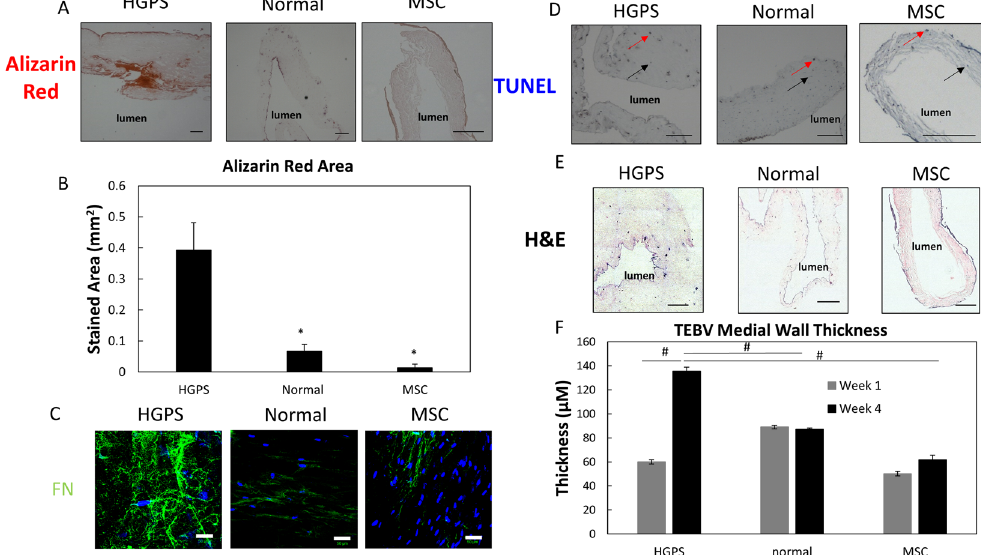
Figure 4. Progeria disease characterization of TEBVs fabricated from MSC or iPSC-derived SMC TEBVs from healthy and Progeria patients. ( A ) Histochemical analysis of HGPS iSMC, normal iSMC, and MSC TEBVs at week 4 with Alizarin Red staining (Scale bar, 200 μ m). ( B ) Quantification of A, total area positive for Alizarin Red. ( C ) Representative images of immunofluorescence staining with fibronectin antibodies at week 4 of perfusion on TEBVs fabricated from HGPS iSMCs, normal iSMCs, and MSCs and seeded with hCB-ECs in the lumen (Scale bar, 50 μ m). ( D ) Histochemical analysis of MSC, normal iSMC and HGPS iSMC TEBVs at week 4 with TUNEL staining. Red arrows indicate TUNEL positive cells and black arrows indicate TUNEL negative cells (Scale bar, 200 μ m). ( E ) Histochemical analysis of HGPS iSMC, normal iSMC, and MSC TEBVs at week 4 with H&E (Scale bar, 200 μ m). ( F ) The average thickness of MSC, normal iSMC and HGPS iSMC TEBVs at week 1 and week 4 based on H&E images in E. n = 3 TEBVs for each TEBV cell type. * P < 0.05, ** P < 0.01, # P <